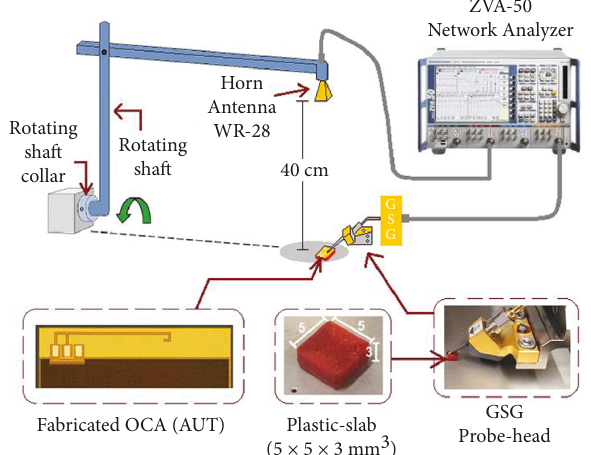
Figure 5: Radiation pattern measurement setup of the antenna under test (AUT) employing Cascade Microtech GSG coplanar probe, WR-28 horn antenna, and Rohde & Schwarz ZVA-50 vector network